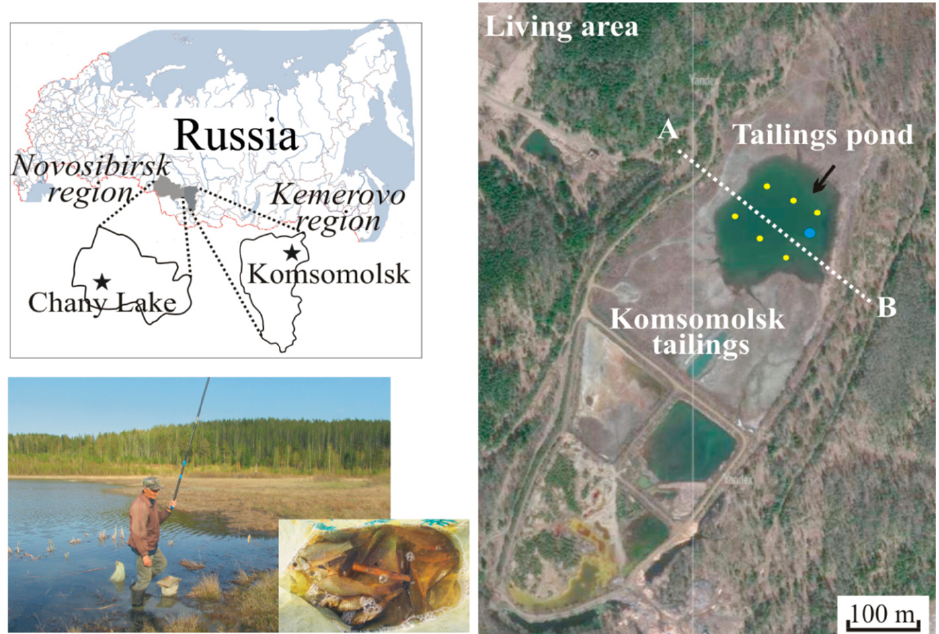
Figure 1. Geographical position of study sites (Komsomolsk settlement and Chany Lake marked with stars on the map), sampling scheme at Komsomolsk pond, and photograph “Fisherman and his catch”. Yellow points are water samples, blue circle is site of catching fish, and white line is the elecrotomography profile.